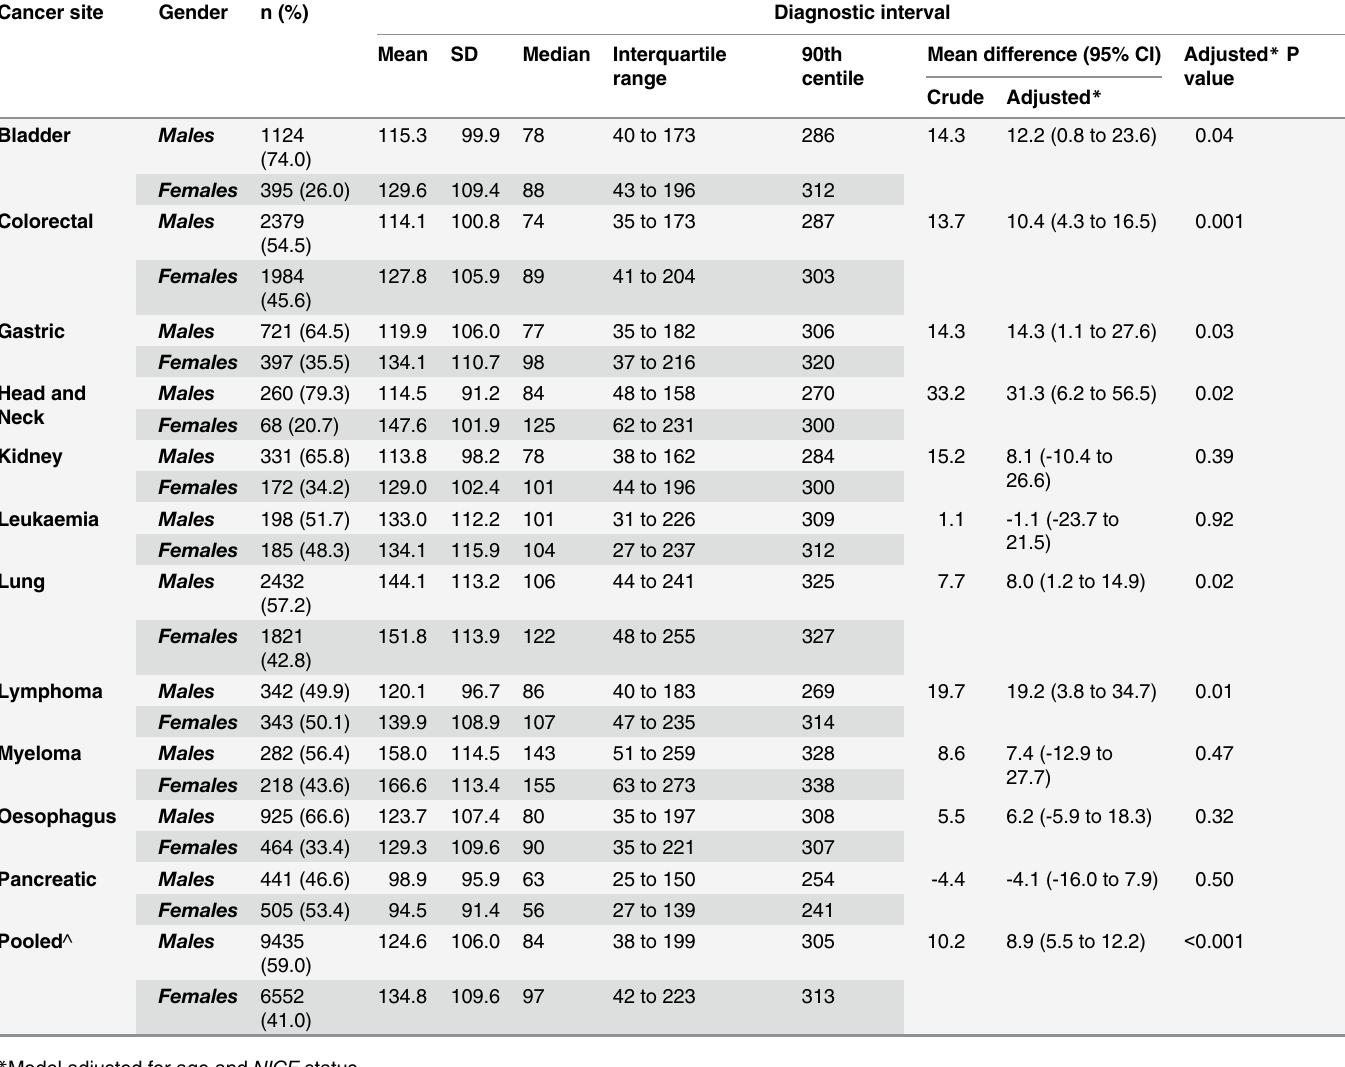
Table 4. Regression analysis of diagnostic interval by gender * in 11 gender non-specific cancers ^ . Cancer